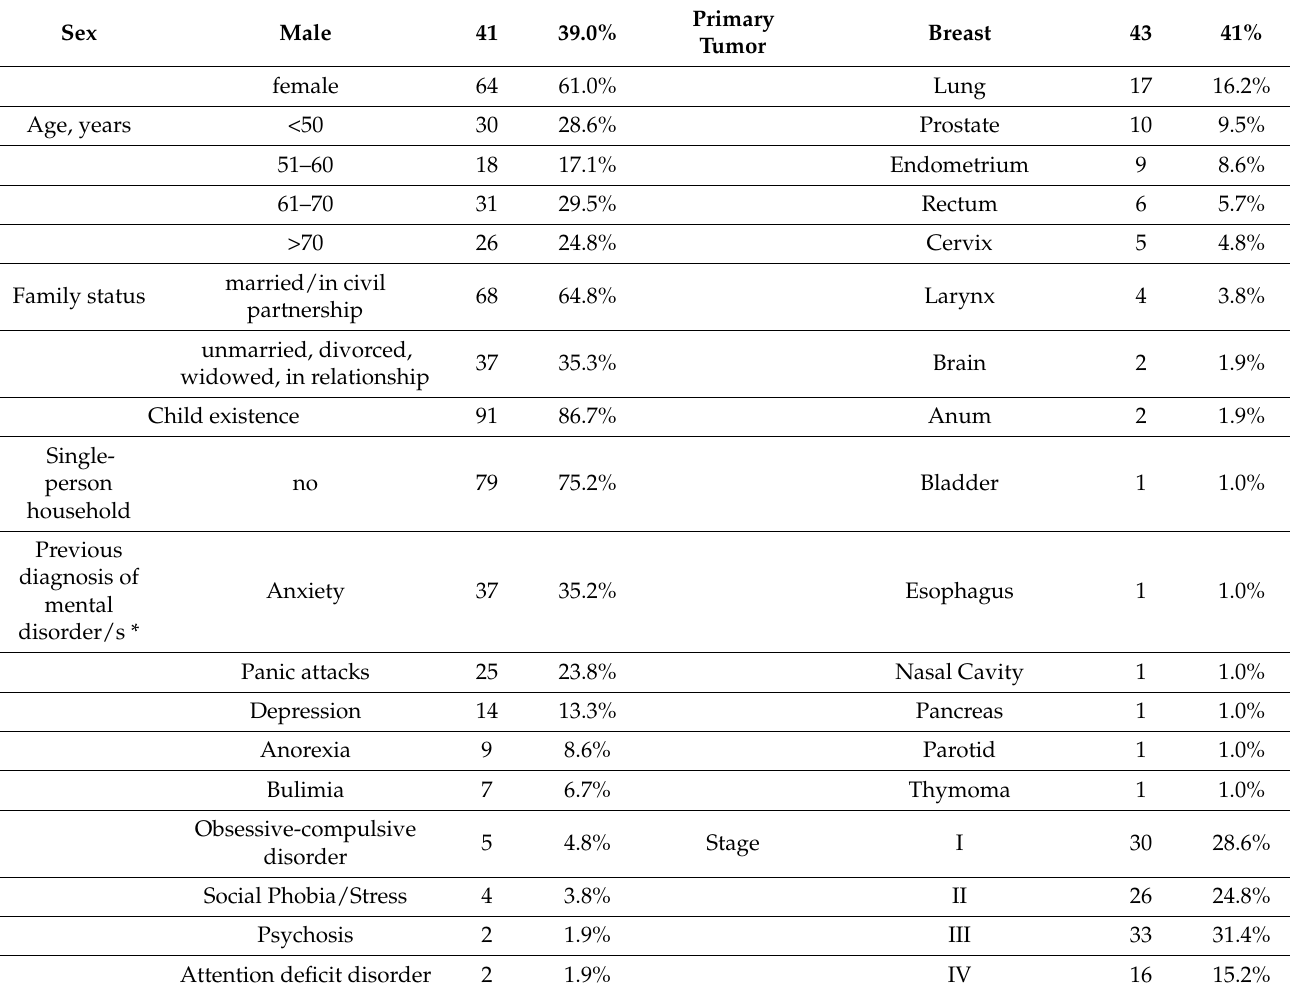
Table 1. Descriptive characteristics of 105 participants in the current